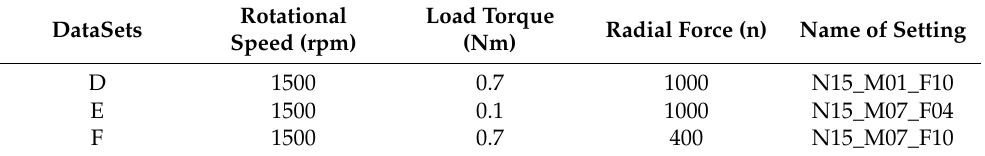
Figure 12. The Bearing Fault Experiment Platform of PU. Table 7. Working conditions of D,E,F dataset on PU dataset.